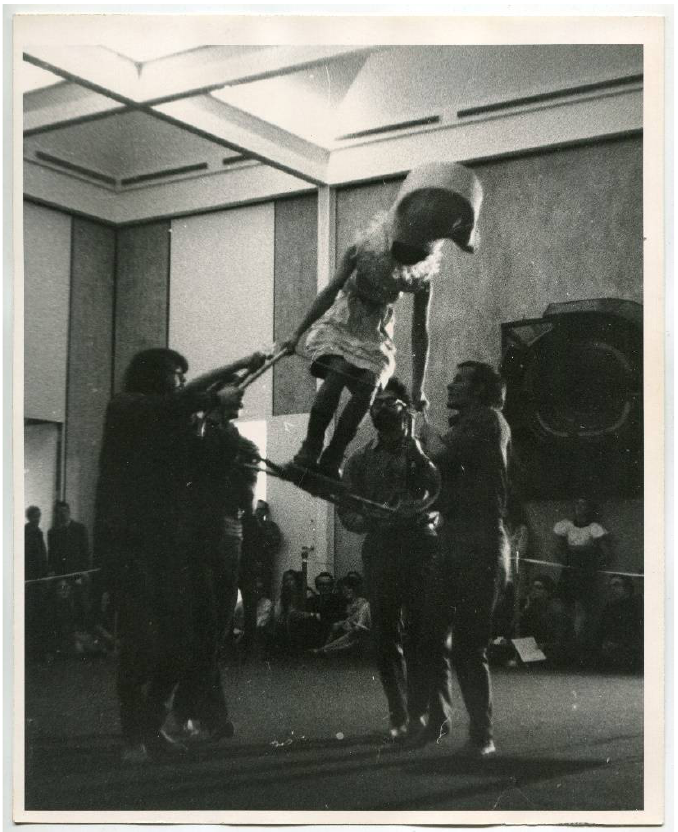
Figure 2. Trisha Brown, Steve Carpenter, Peter Pole, Elie Roman, and Melvin Reichler in Dance with the Duck’s Head (1968). December 6, 1968. Photograph by Jeanie Black. Courtesy of Trisha Brown Archives and Jerome Robbins Dance Division, The New York Public Library.